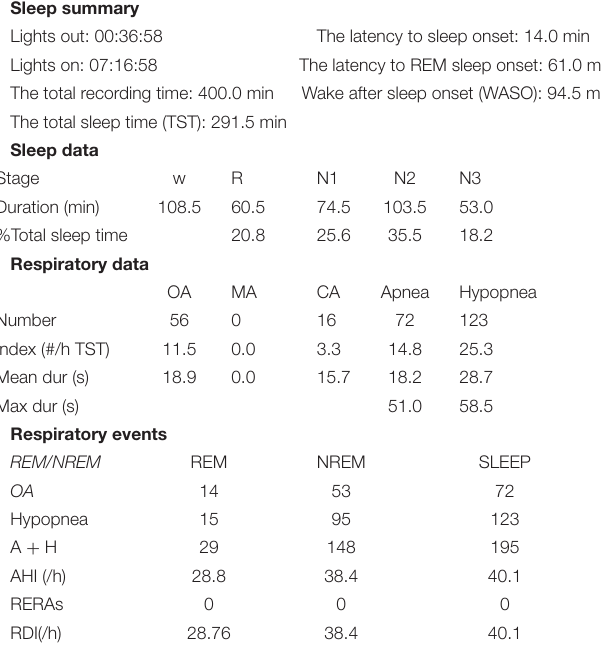
TABLE 1 | Polysomnography